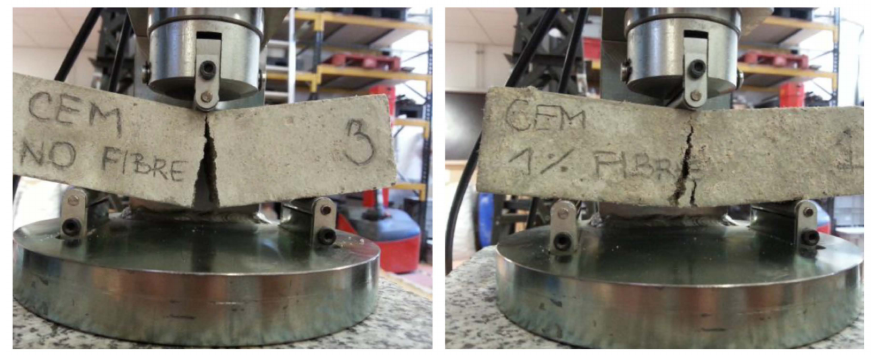
Figure 13. Failure patterns of flexural tests.